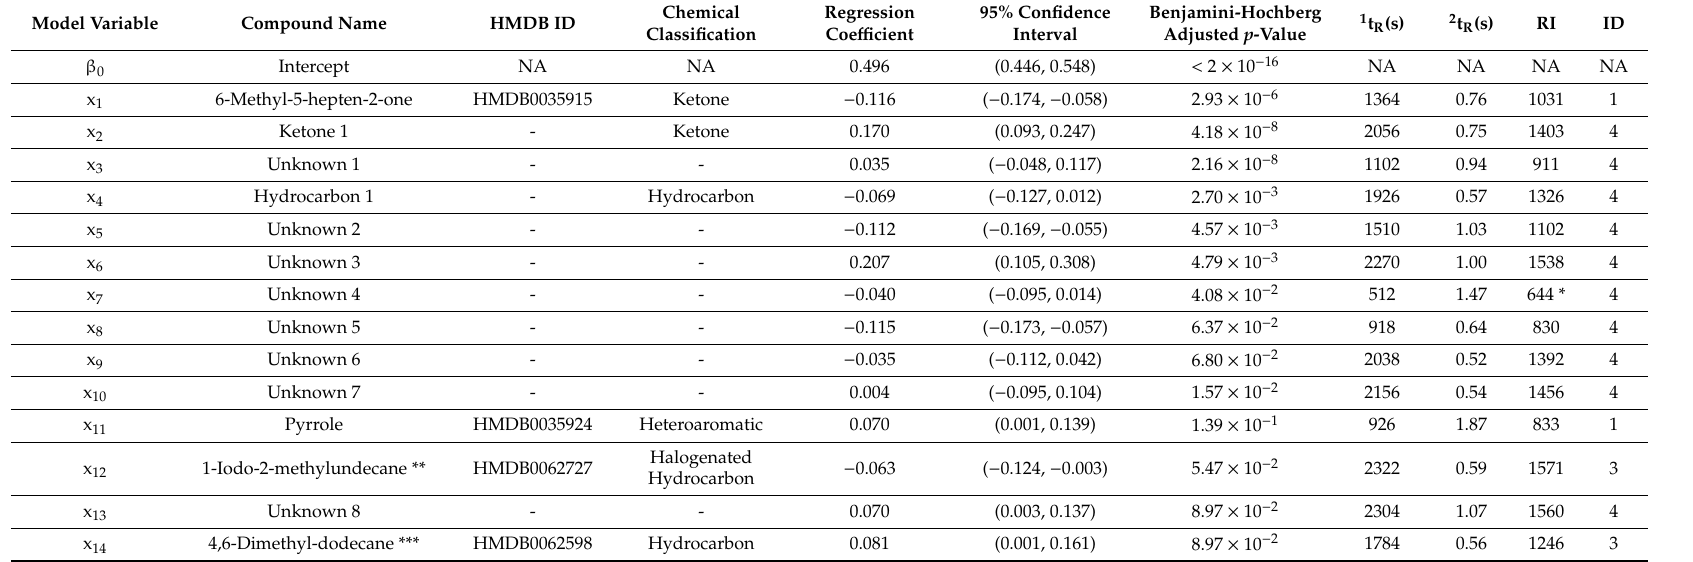
Table 1. Results for individual terms in the multiple regression model. Metabolite information includes: compound name, Human Metabolome Database (HMDB) ID, chemical classification, regression coe ffi cient, confidence interval, t-test corrected p -value, 1 st dimension retention time, 2 nd dimension retention time, retention index, and ID confidence level using the guidelines set by the Metabolomics Standards Initiative. Retention indices denoted with * have been extrapolated. Compounds denoted with ** have assigned names other than the first spectral hit, using NIST non-polar RI database for confirmation. Compounds denoted with *** fell within 6% of NIST reported non-polar